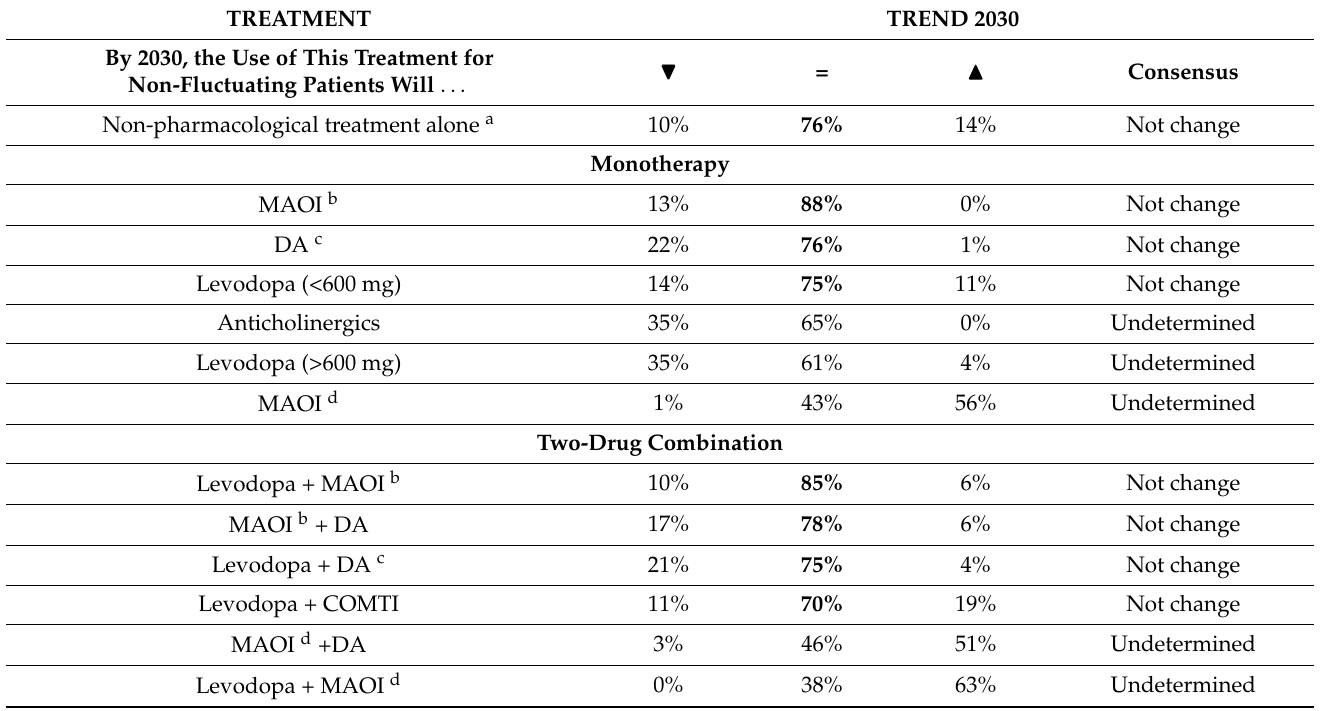
Table 4. Treatment by patient profile: future